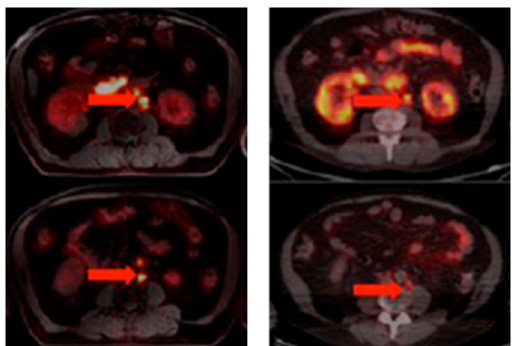
Figure 8. [ 68 Ga]Ga-RM2 (left) vs. [ 68 Ga]Ga-PSMA-11 (right) PET/CT images of PCa lesions (red arrows) in a patient with LNM. This research was originally published in the Journal of Nuclear Medicine (JNM) [122].